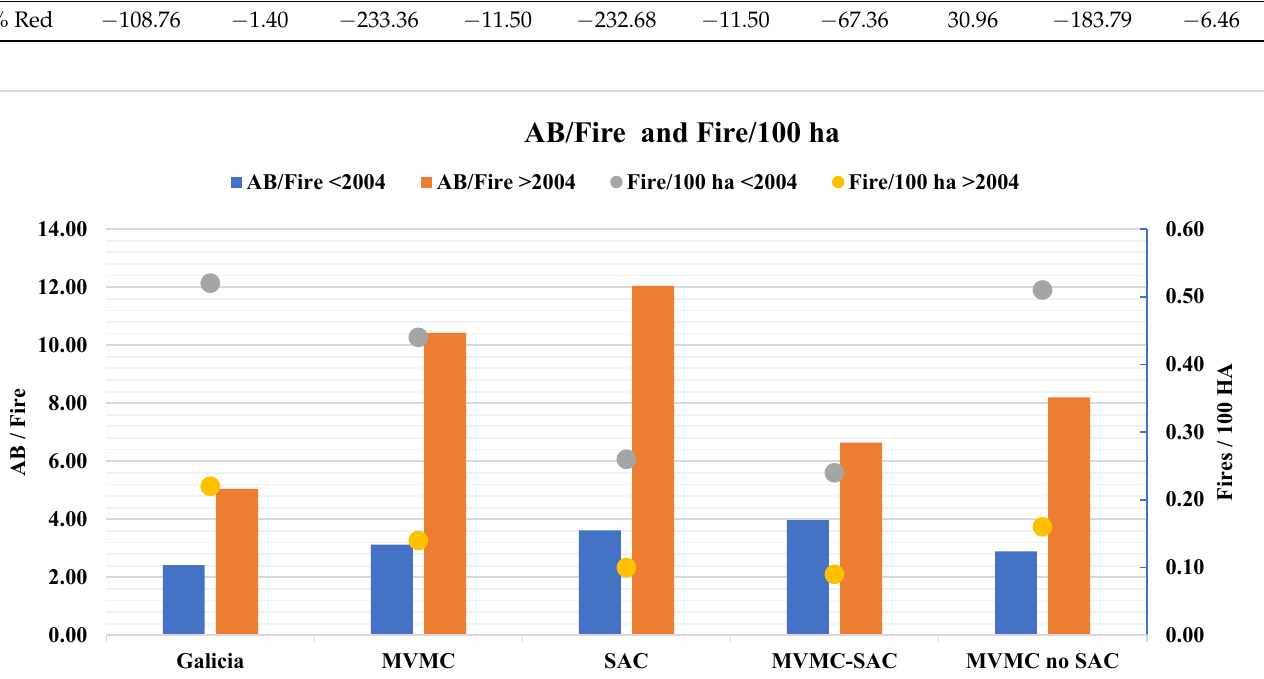
Figure 12. Fire rate (yellow and grey dots) and area burned by fire in each territorial study unit before and after 2004. Fire rates (periods 1999–2004, and 2005–2014) are also included. The area burnt was higher after 2004 in all the territorial units analysed, while fire rates were lower for the same period.